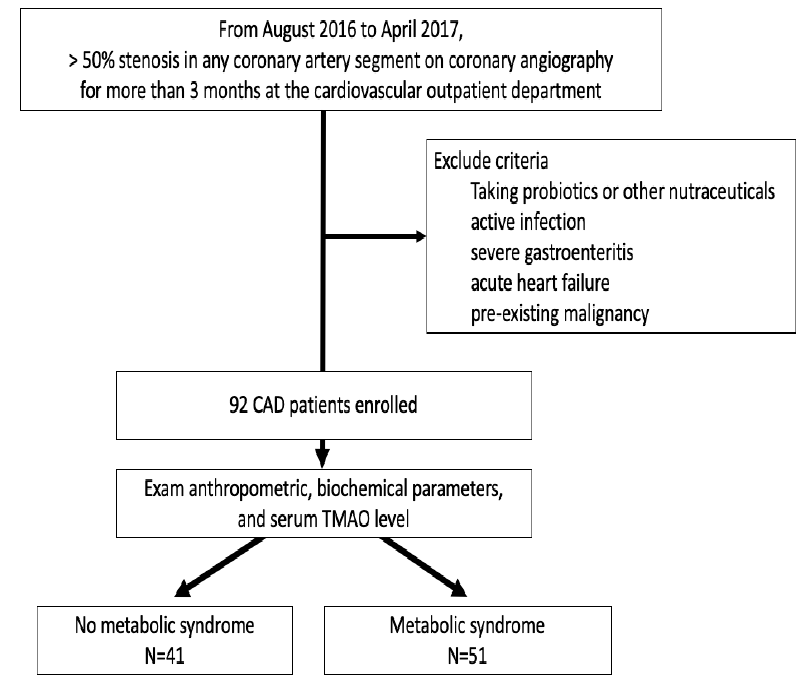
Figure 1. The study flow chart.